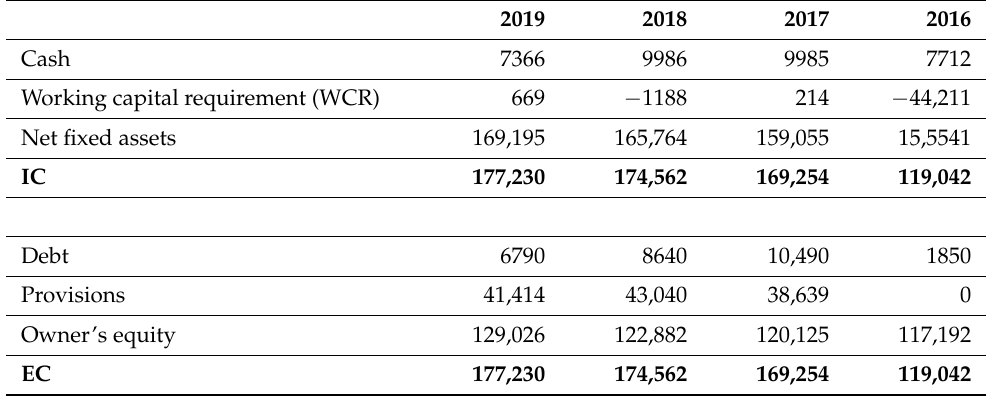
Table 3. Managerial balance sheet of PEC Geotermia Podhala´nska S.A. (PLN thousand).